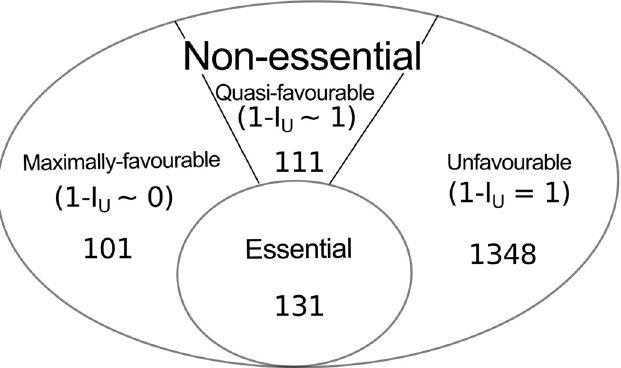
Fig 1. Categorization of reactions depending on their importance in experimentally observed biomass production. A total of 1691 reactions are shown excluding 42 fixed biomass